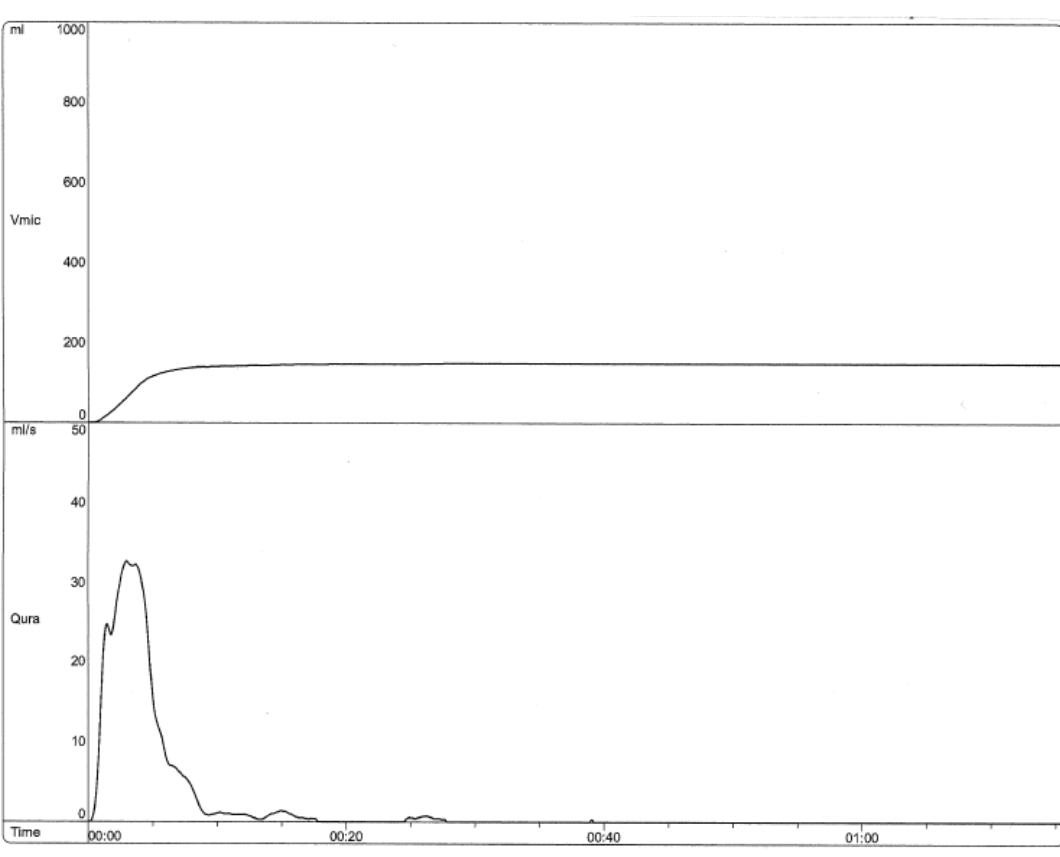
Figure 3. Uroflow (12/2018) Post 8 visits to Pelvic Floor Physical Therapist (bell shaped with some terminal dribbling).